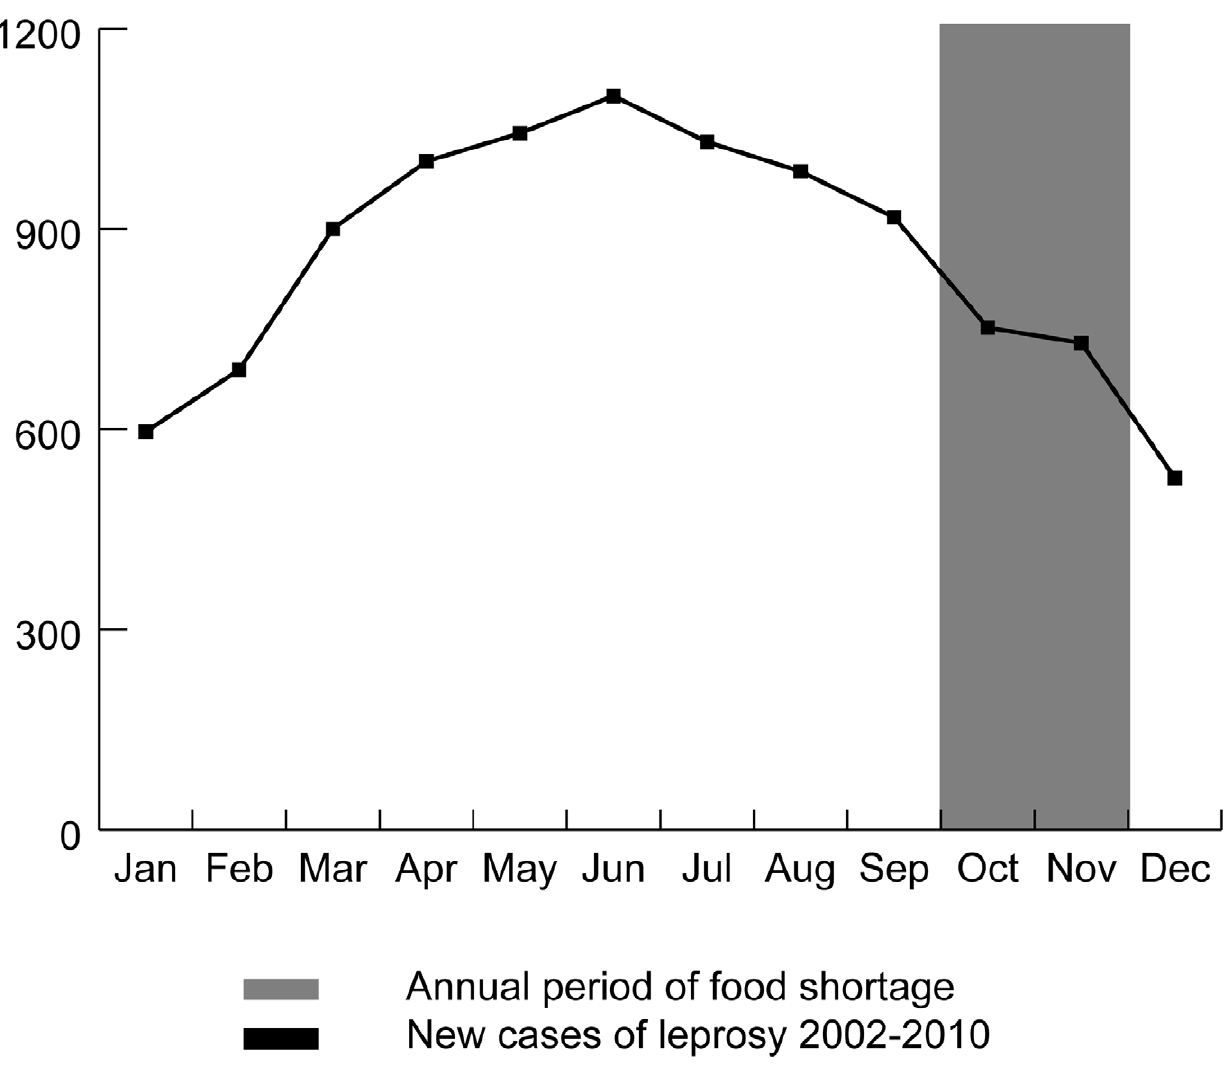
Figure 1. Seasonal pattern of leprosy cases in the study area (2002–2010) in relation to the annual period of food shortage.